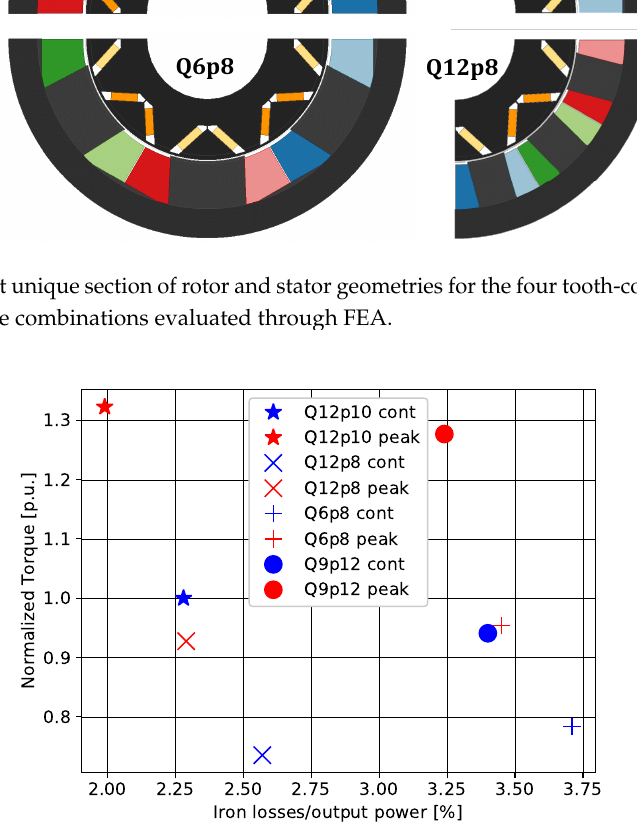
Figure 2. Numerical comparison of the different pole slot combinations for peak and continuous operation at 300 Hz electrical frequency. All machines have the same volume, airgap flux density and current density ( A cont and A peak ), see Table 3. The torque is normalized to the Q12p10 machine in continuous